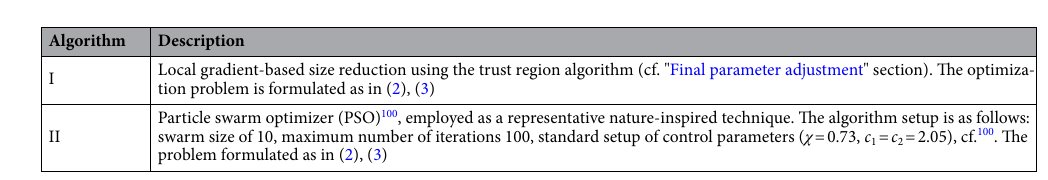
Table 5. Benchmark algorithms.